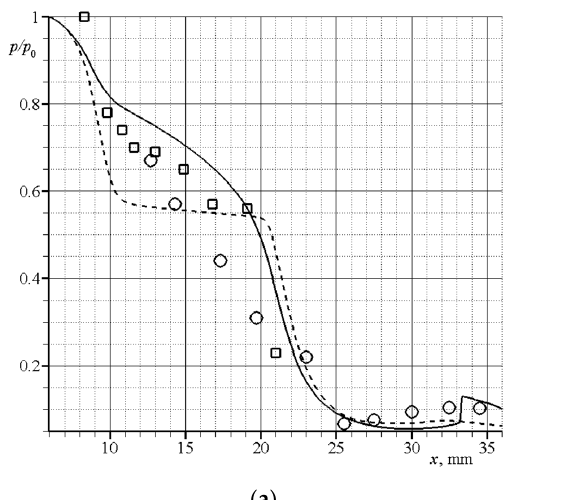
Figure 6. Distribution of pressure ( a ) and Mach number ( b ) on the axis 0 y  in the steady gas flow calculated with different numbers of cells: the solid, dashed, and dash ‐ and ‐ dot lines correspond to Different symbols in Figure 7a (circles and squares) show the results of static-pressure 51783 N  , 207132 N   , and 828528 N   , respectively. measurements performed on disks that differed in the location of pressure holes. c c c